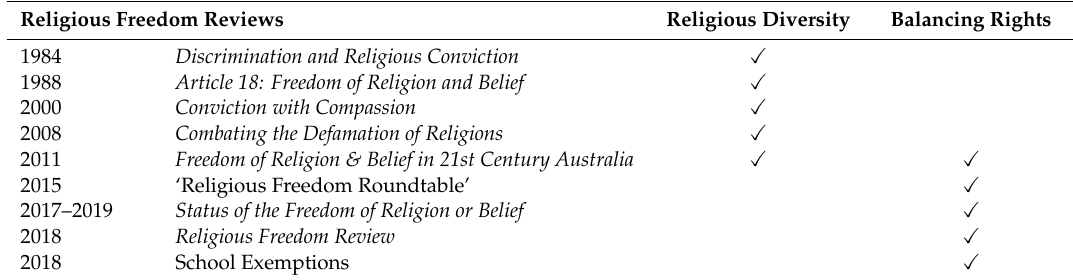
Table 2. The dominant problematisation in the religious freedom